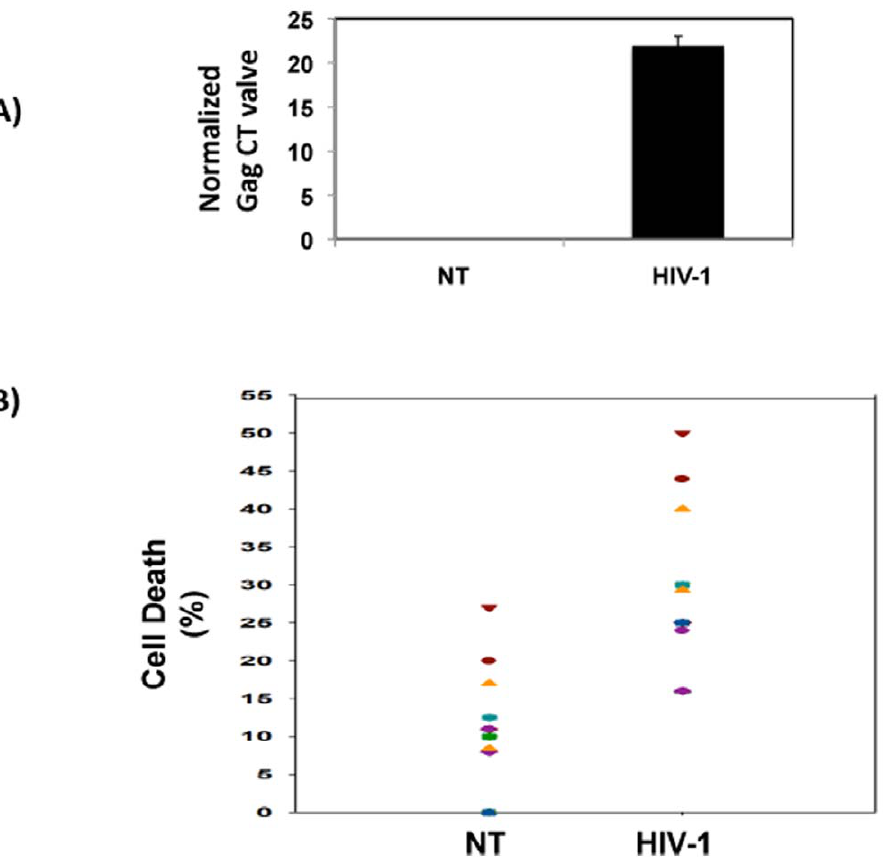
Figure 1. Infectivity in and cell death in PBMCs used for analyses. (A) Normal donor PBMCs were infected with HIV-1 or mock infected for seven days. RNA was isolated and tested for Gag by RT-PCR. Gag CT values were obtained by using the endogenous control for normalization. Figure shows average CT value from 16 independent donors. (B) After seven days, post-infection cell death was assessed by trypan blue dye exclusion method. Dot blot represents percentage of cell death in uninfected (NT) and infected (HIV-1) PBMCs from 16 independent donors.